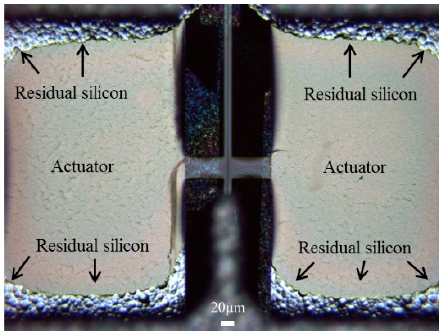
Figure 26. Arrows in the microscopic picture show the residual silicon around corners of the actuators after DRIE. Picture taken from the backside of the actuators.